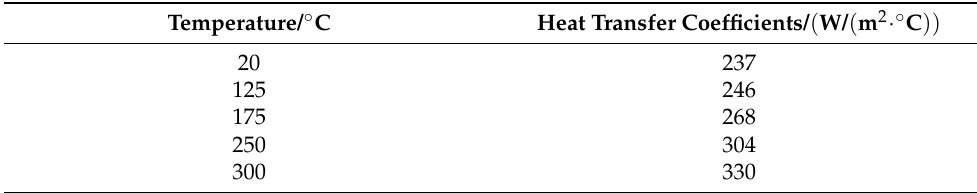
Table 4. The real heat transfer coefficients distribution.